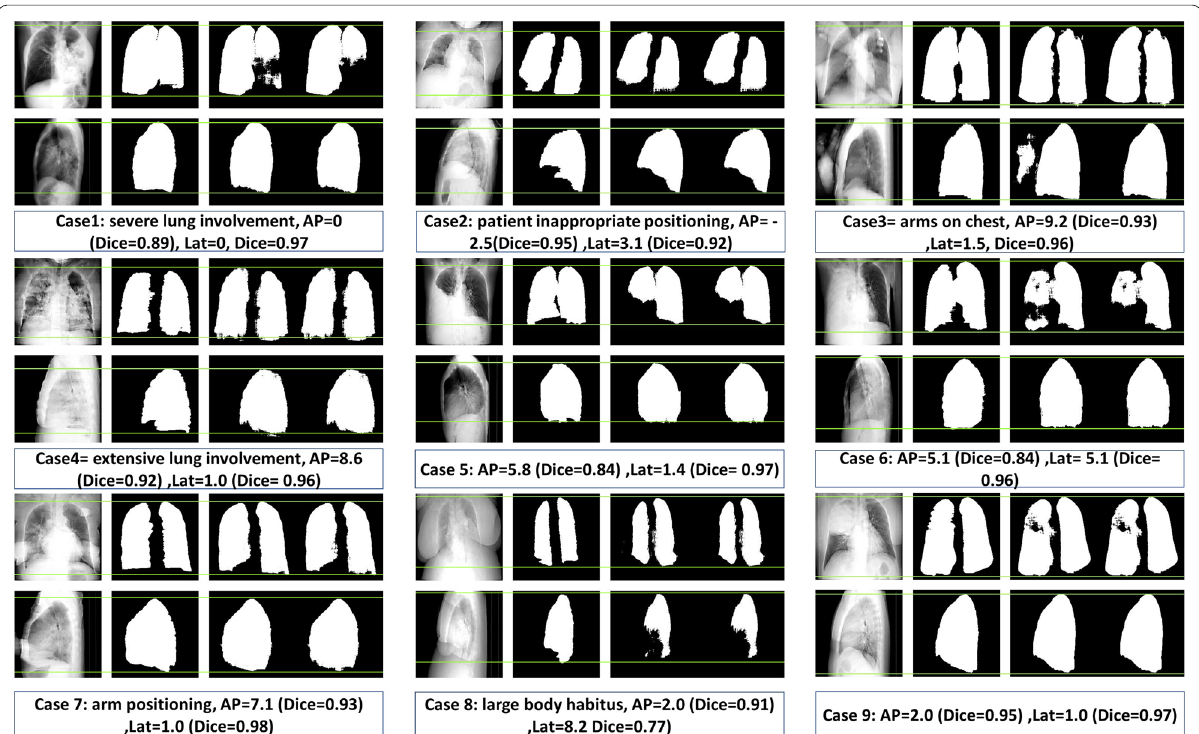
Fig. 5 Examples of segmentation by the DL model in challenging cases. From the left to right: the projection image, the ground truth segmentation, the output of the DL network segmentation, the segmentation after post-processing. The upper row is for AP, whereas the lower row is for the lateral view. The error (Dice) for AP and lateral views are reported in the bottom of each panel. The line (green) shows the desired exact lung boundaries in the inferior and superior